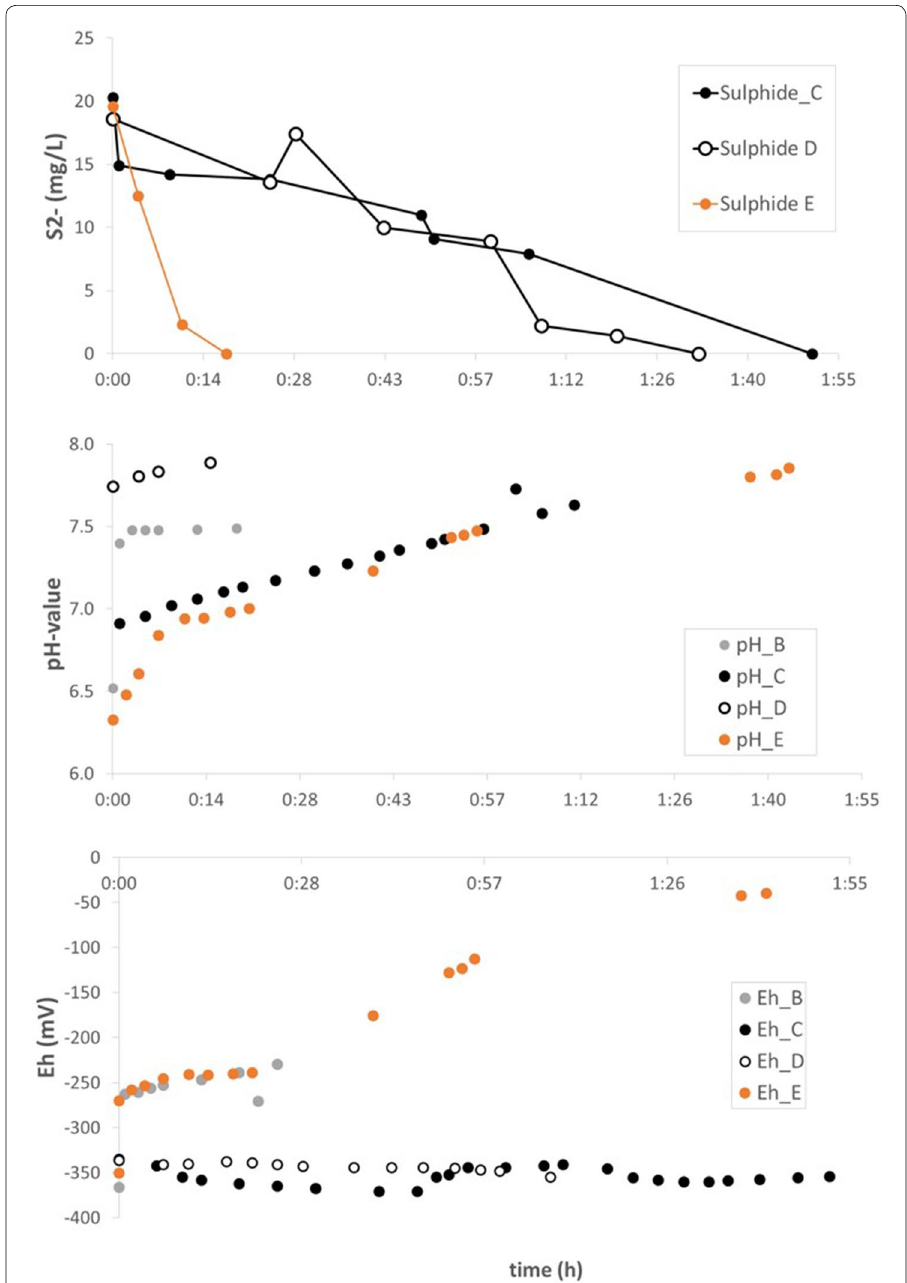
Fig. 7 Color change of the thermal water collected from the reaction container after addition of FeCl 3 (experiment E). Numbers indicate sample collection in minutes after FeCl 3